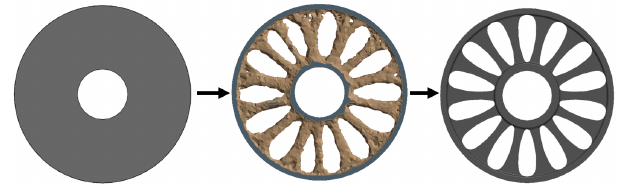
Figure 18. Rope wheel optimization process.